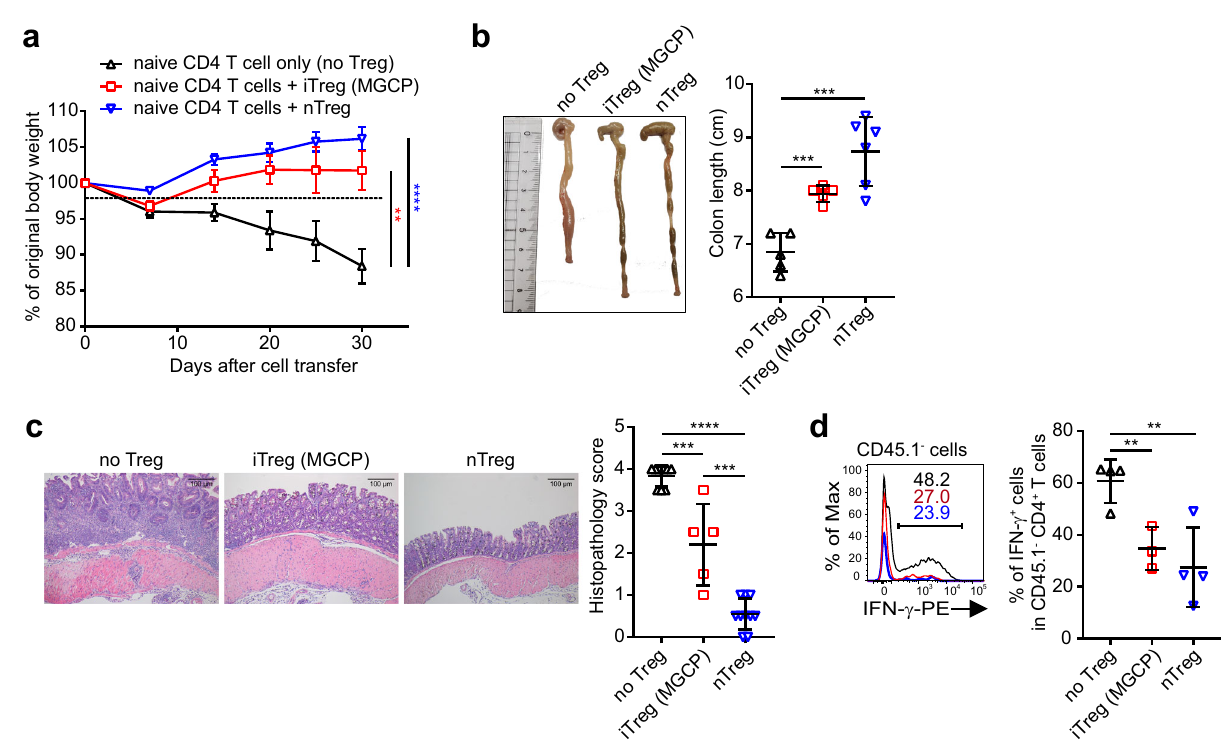
Fig. 3 MGCP promotes functionally active Treg cell differentiation. a – d iTreg cells were generated in vitro by co-culture of MGCP-treated splenic DCs with naive CD45.1 + CD4 + T cells (CD45.1 + CD4 + Foxp3 − CD44 lo CD62L hi ). iTreg cells (CD45.1 + CD4 + Foxp3 + ) were FACS sorted and adoptively transferred into Rag1 − / − mice along with naive CD4 + T cells (CD45.2 + CD4 + Foxp3 Thy1.1 CD44 lo CD62L hi ). CD4 + naive T cells alone were transferred as controls (no Treg group). Colitis development and severity were assessed by body weight change ( a ) and changes in colon length ( b ). Representative colon sections were stained with H&E ( c ) and histopathology score was measured. Frequency of IFN- γ + donor naive CD4 + T cells (CD45.2 + ) was assessed ( d ) in colonic lamina propria. Each dot represents an individual mouse. Data are analyzed from 4 independent experiments with minimum 10 mice ( a ). Results are analyzed with pooled data from 2 independent experiments with minimum 5 mice ( b , c ). Graph is presented with representative data of 2 independent experiments with minimum 3 mice ( d ). Graph plots show the mean ± SEM. a ** p < 0.01, **** p < 0.0001 or ±SD. b – d ** p < 0.01, *** p